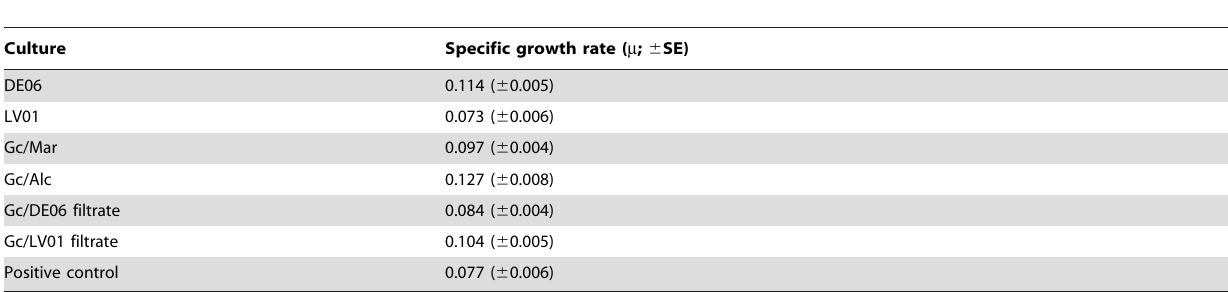
Table 2. Specific growth rate ( m ) of Gymnodinium catenatum (Day 0 to Day 25) when grown with different microbial communities.